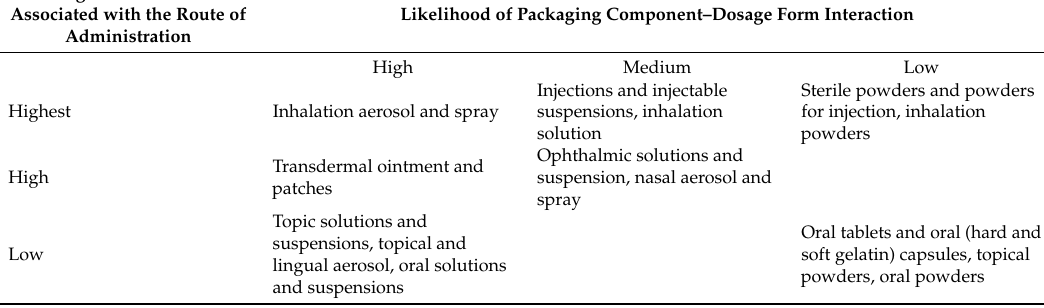
Table 3. Assessment of drug product leachables associated with pharmaceutical packaging / delivery systems (modified from “FDA / CDER / CBER risk-based approach to consideration of leachables” (USP—General chapter < 1664 > )